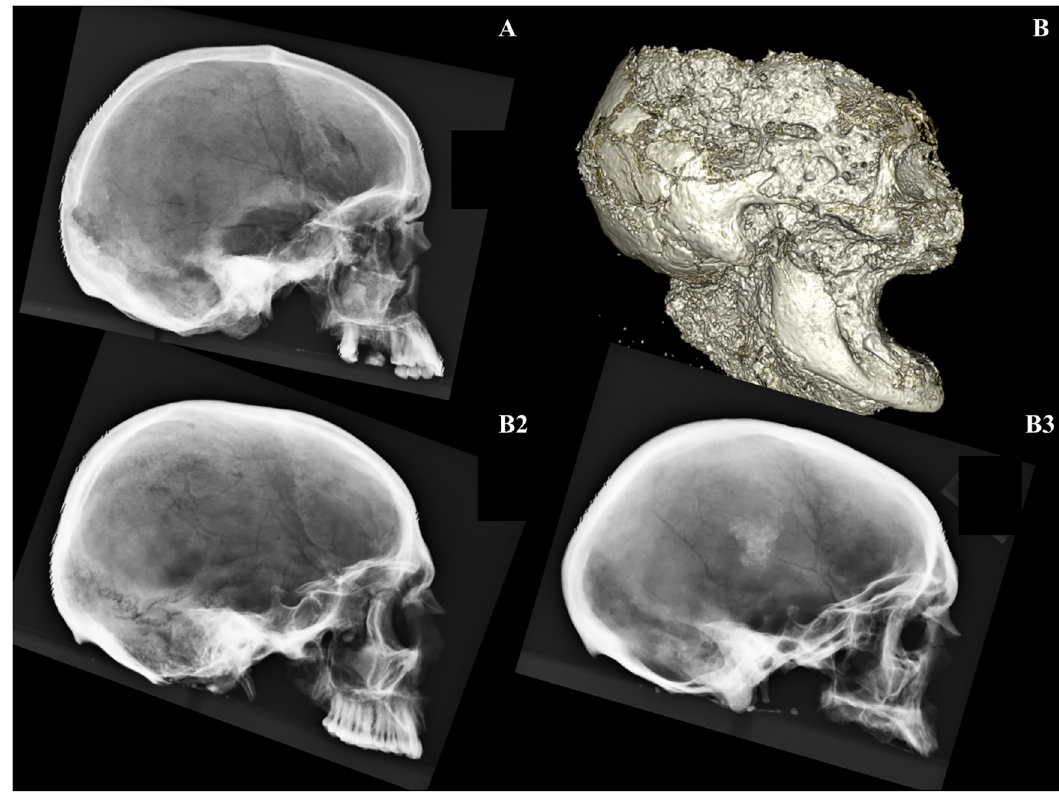
Fig 8. YNH4 lateral radiographs. YNH4 A has a damaged splanchnocranium. The fragile condition of the YNH4 B skull required a CT scan while still in matrix. Radiographs by GJC, TG and NAP